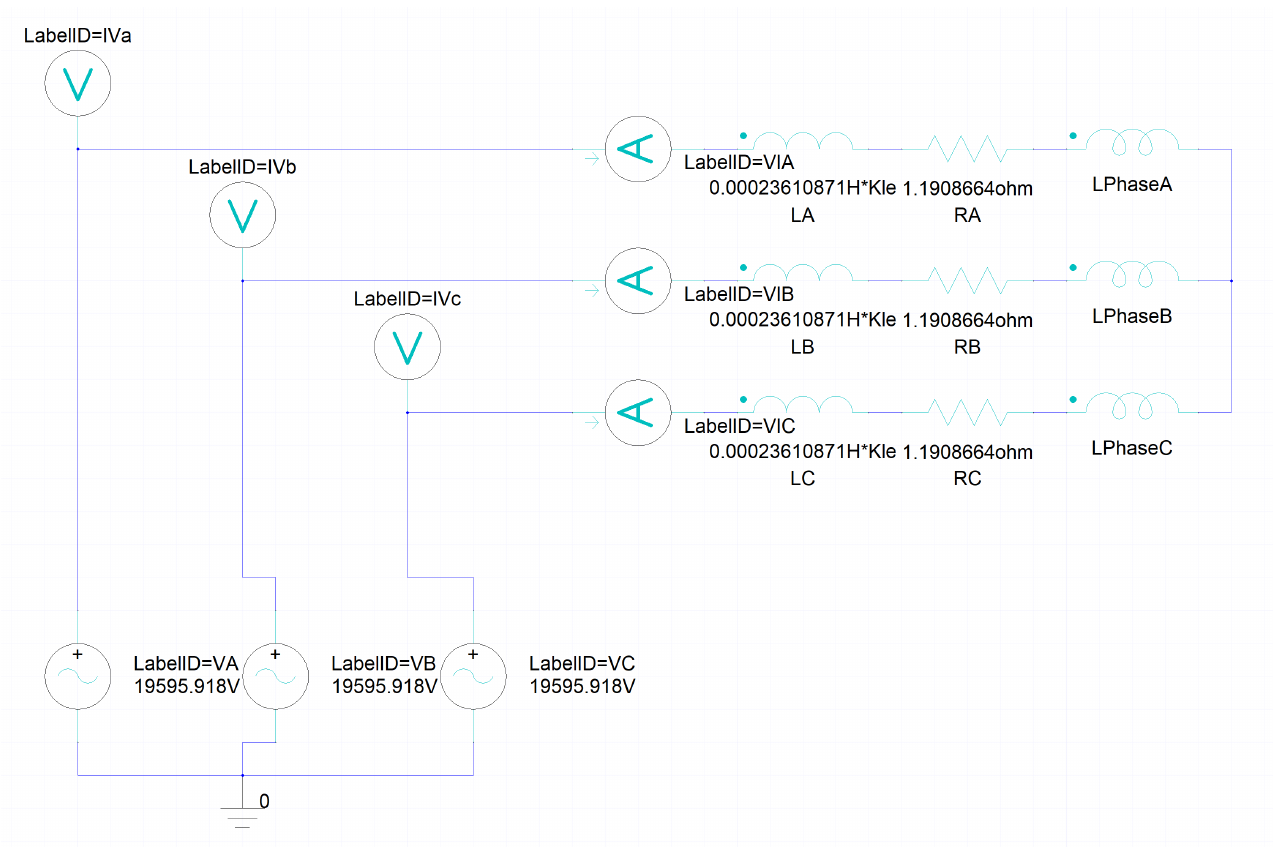
Figure 5. The external circuit of stator